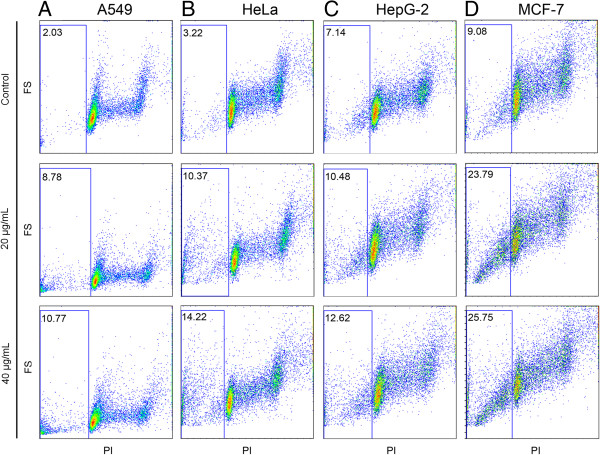
Grailsine-Al-glycoside triggered significant apoptosis in A549, MCF-7, and Hela cells. Cells treated with different concentration of Grailsine-Al-glycoside for 36 hrs before stained with propidium iodide and underwent flow cytometry analysis. The apoptotic cells were measured by sub-G1 population. Grailsine-Al-glycoside induced over 2 fold increase of apoptosis in A549 (A), Hela (B), and MCF-7 (D) cells but moderate increase in HepG2 cells (C).